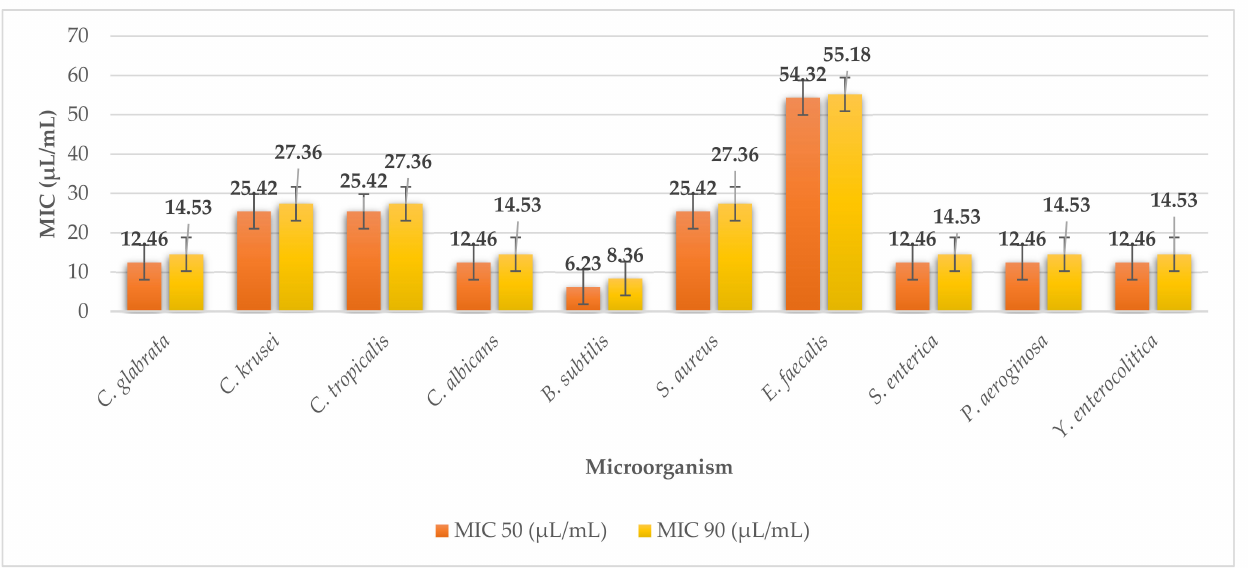
Figure 6. MIC 50 and MIC 90 of wakame.